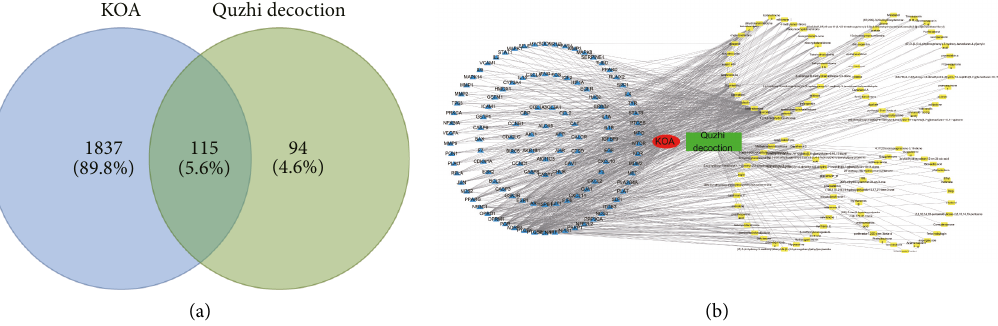
Figure 5: Network pharmacology construction. (a) Venn diagram showing the intersection of action targets of Quzhi decoction and knee OA targets; (b) Quzhi decoction treatment of the knee OA active ingredient—common targets network. The blue triangle represents the common targets, and the yellow rectangle represents the active components of Quzhi decoction. OA